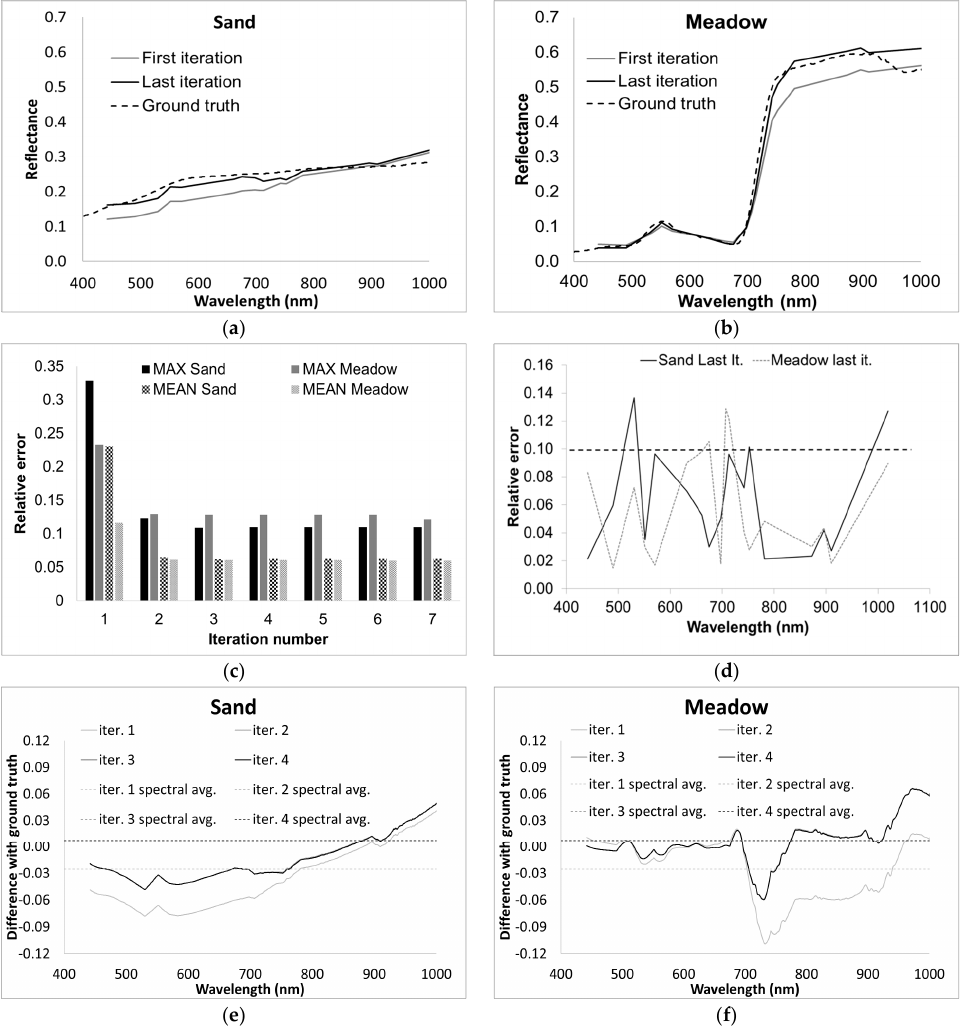
Figure 12. Spectral reflectance retrieved by the atmospheric correction procedure at iteration step 0 (grey) and after reaching asymptotic value compared with measured (ground truth) data (dashed line) for the “sand” pixel ( a ) and for the “meadow” pixel ( b ). ( c ) Max and mean relative error as the iteration number increases. ( d ) Relative error as a function of the wavelength between asymptotic values and ground truth data. Difference between the measured ground truth and the retrieved reflectance for the “sand” ( e ) and the “meadow” ( f ) pixels for the first 4 iterations; after the second iteration the curves overlap.